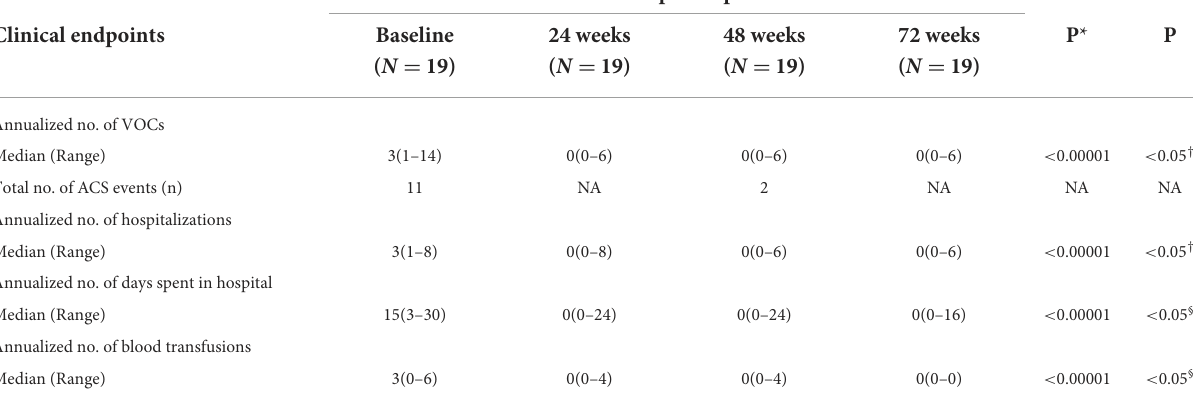
TABLE 2 Clinical observations of patients with sickle cell disease (SCD) at baseline and follow-up time points.